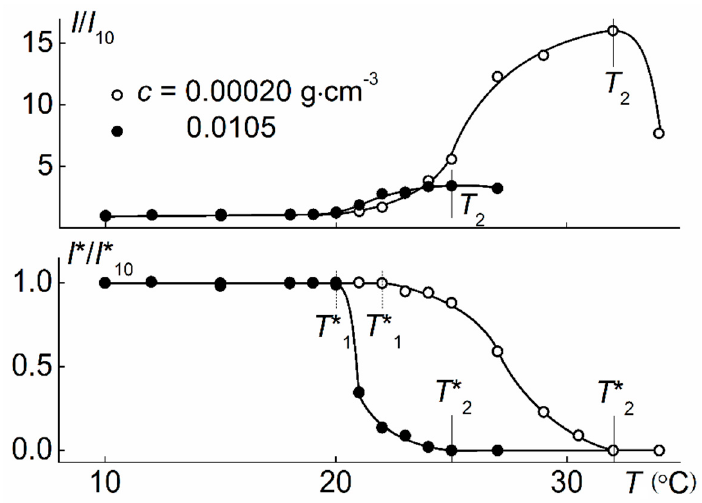
Figure 10. The temperature dependences of relative light scattering intensity I / I 10 and relative transmittance I * / I * 10 for aqueous solutions of APE-g-PiPrOx. I 10 and I * 10 are intensities of light scattering and optical transmittance at T = 10 °C, respectively.